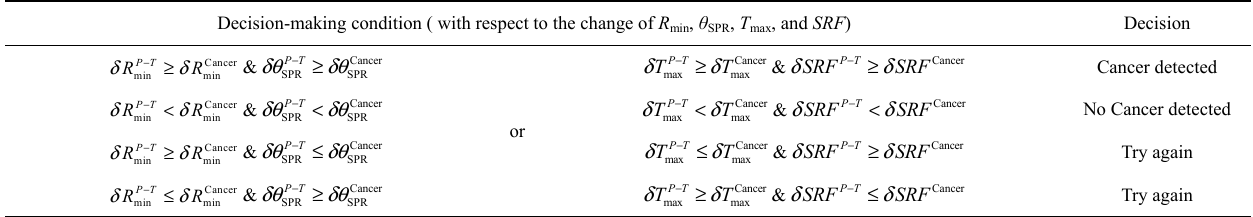
Table 5 Decision-making condition based upon different situations which happening to detecting